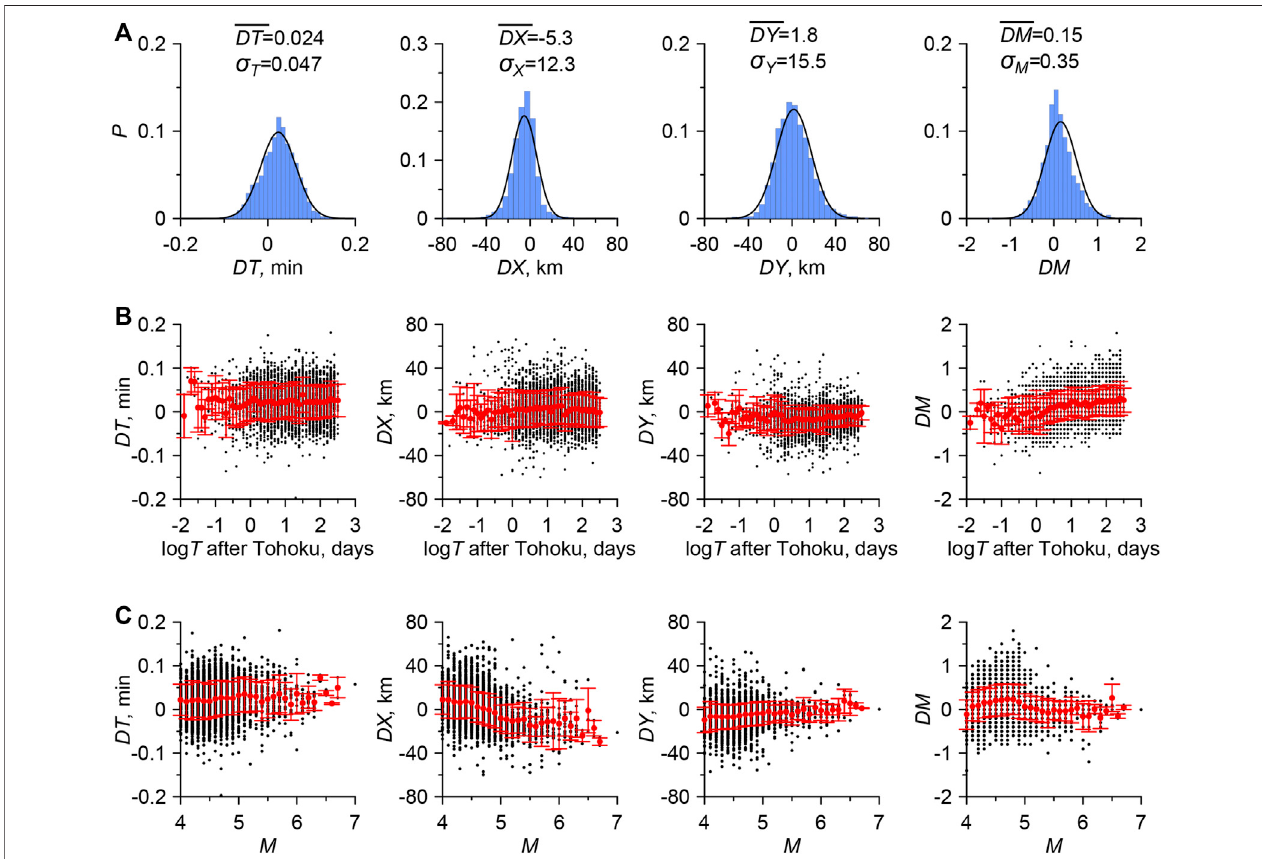
FIGURE4|(A) Distributionsof DT , DX , DY , DM .Thedependence ofvarianceandmeanvaluesontimeafterthemainTohokushock (B) ,andonthemagnitudeof events (C) . Red dots and bars are population mean values and standard deviations.